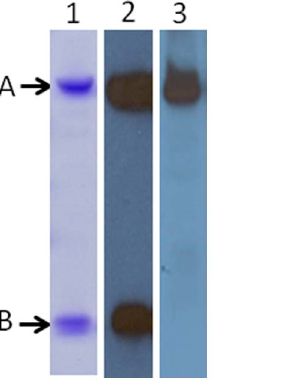
(Figure S1; panel A). Two consensus pAb binding peptide sequences corresponding to the B-subunit (GKIEFSK and LQSAQLT) are 100% conserved in all seven Stx2 subtypes. The GKIEFSK peptide (Stx2a B-subunit 6–12aa) presents a structure mapping to a large surface area of the B-subunit protein (Figure S1; panel B) that would be available for antibody binding. The LQSAQLT peptide (St2a B-subunit 39–45aa), however, maps to the inner ring of the B-subunit pentamer (Figure S1; panel C) and in the presence of the A-subunit, antibody binding to this epitope might be minimized (Figure S1; panel D). Although the DTFTV peptide (Stx2a B-subunit residues 17–21aa) is identical in Stx1 B-subunit, the lack of pAb binding to Stx1 argues that these epitopes must differ structurally between the two B-subunits. One possible explanation is found in the surrounding sequence of residues (Stx2a B-subunit residues 1–31aa) where Stx1 shows considerable divergence with 13 mismatched amino acids including an added proline.